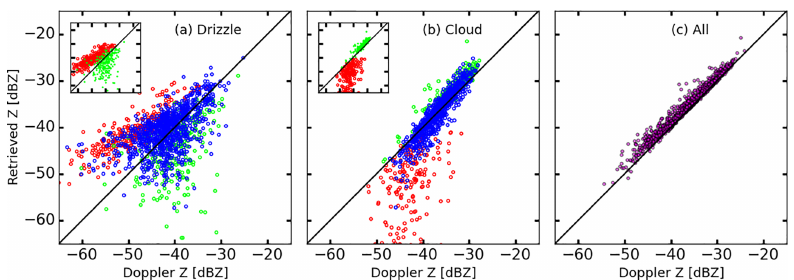
Figure 11. Radar reflectivities from our retrieval (“retrieved Z ”) plotted against those derived from the Doppler spectral decomposition (“Doppler Z ”). Drizzle, cloud, and total reflectivities are shown separately in (a) , (b) , and (c) , respectively. The points are color coded according to their location in the cloud. Red points are from the cloud base area, blue points are from the middle of the cloud, and green points are from the cloud top region (see the text for details). The insets in (a) and (b) show the same plot with the blue points excluded. The diagonal line is the one-to-one